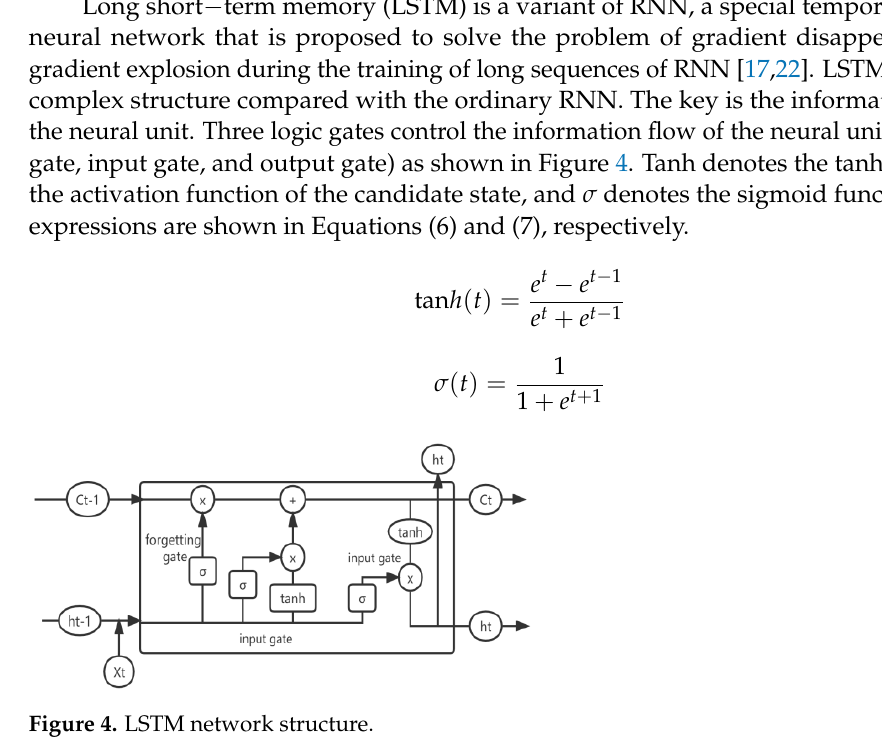
Figure 5. GRU network structure. Traditional convolutional neural networks are generally considered less suitable for time sequence modeling. In contrast, a temporal convolutional network (TCN) [24,25], a new type of neural network based on causal convolution, dilated convolution, and resid- ual connections, has model predictions that are only influenced by historical data and not